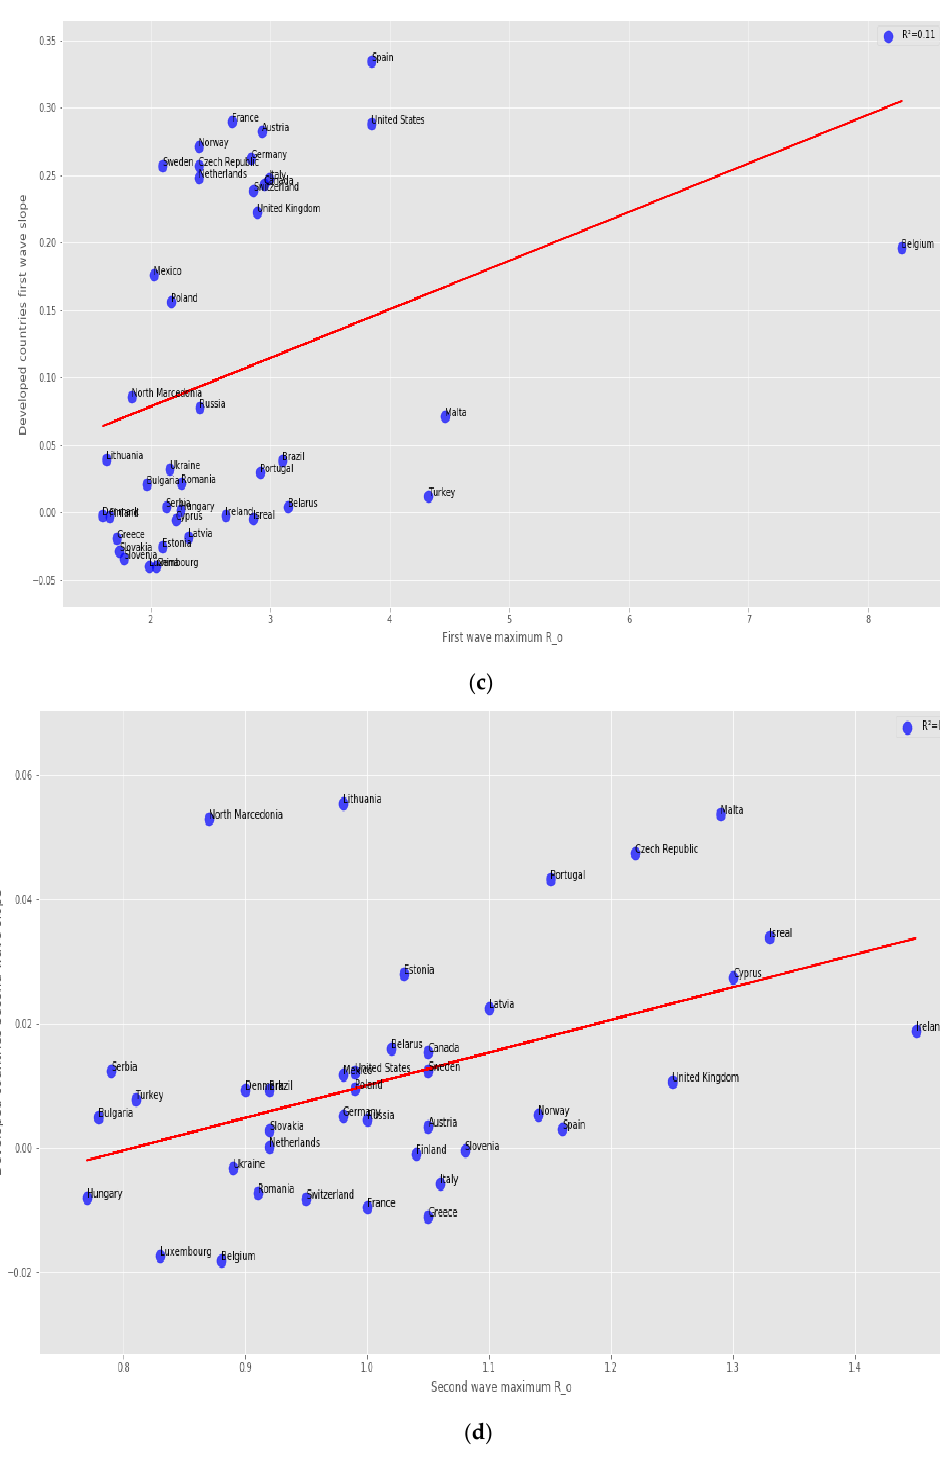
Figure 5. Regression plots for developed countries of ( a ) first and ( b ) second wave exponential regression slope versus CHR/GDP, ( c ) first and ( d ) second wave maximum R 0 of the new cases curve. ( a ): LinregressResult slope = 0.0320468, intercept = −0.16158, r value=0.6481, p value = 4.62 13 × 10 −6 , stderr = 0.00603, R-squared = 0.42, RMSE for linear regression = 0.09359760581, ( b ): LinregressResult slope = −0.0010489, intercept = 0.01994, r value = 0.1340845, p value = 0.4094462, stderr = 0.001258, R-squared = 0.018, RMSE for linear regression = 0.018583749, ( c ): LinregressResult slope = 0.03612, inter- cept = 0.0062, r value = 0.3299, p value = 0.0352, stderr = 0.0165, R-squared = 0.109, RMSE for linear regression = 0.116, (d): LinregressResult slope = 0.05223, intercept = −0.0421, r value = 0.434366, p value = 0.0051, stderr = 0.01757, R-squared = 0.18867, RMSE for linear regression = 0.01689.